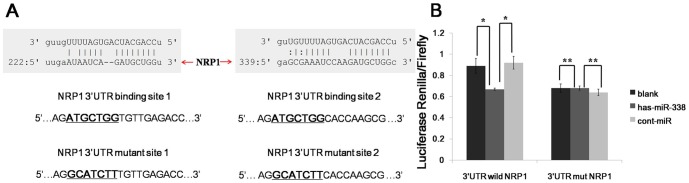
miR-338 decreases NRP1 expression by directly targeting its 3′UTR.(A) Luciferase reporter plasmids were constructed by the insertion of the full-length NRP1 3′UTR into a region immediately downstream of the luciferase gene. The sequences of two predicted miR-338 binding sites within the NRP1 3′UTR, including thefull-length wild-type UTR and a mutant binding site, are shown. (B) The relative luciferase activity was analyzed after the above reporter plasmids or a control reporter plasmid were co-transfected with miR-338 mimics or control mimics into MKN45 cells. The data represent the means±s.d.; * p<0.01, ** p>0.05.